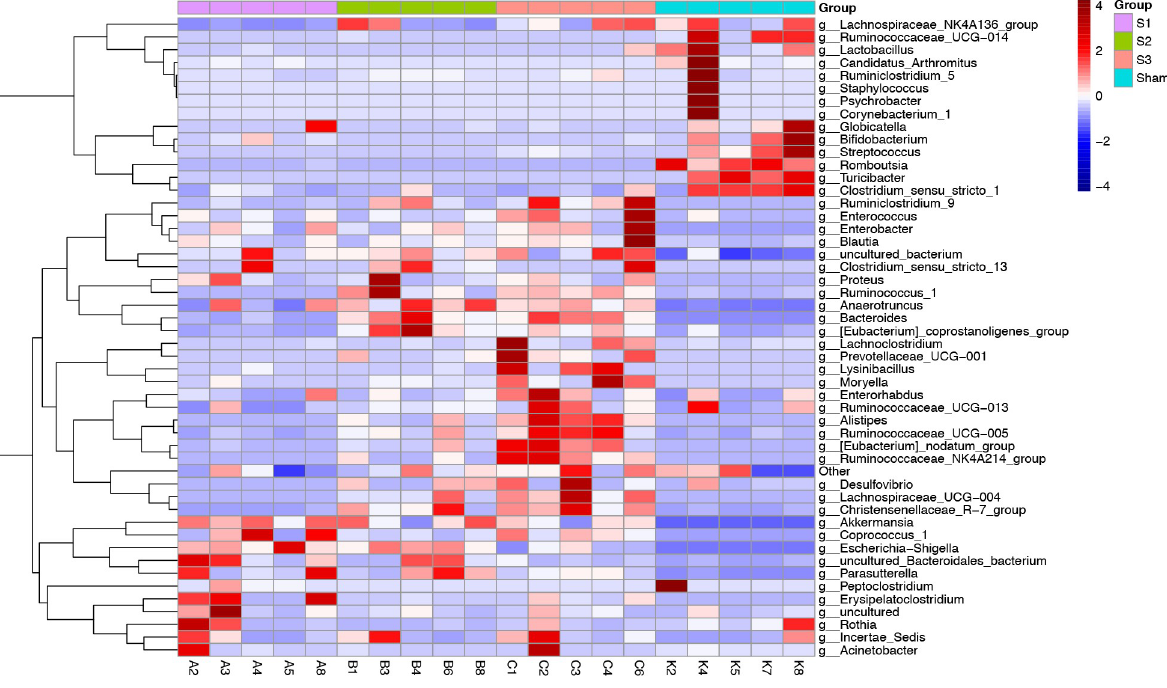
Fig 8. Heatmap analysis at the genus level among four